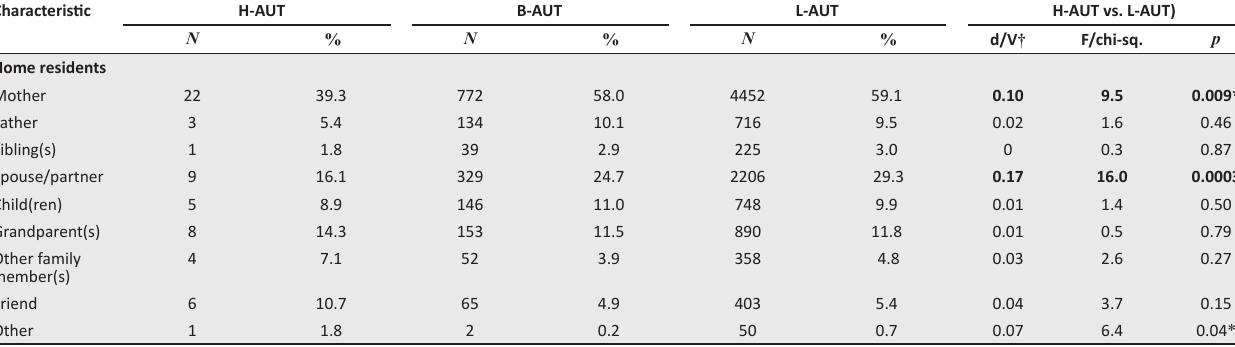
TABLE 1 (Continues...): Demographic characteristics of participant groups ( N = 8918). Characteristic